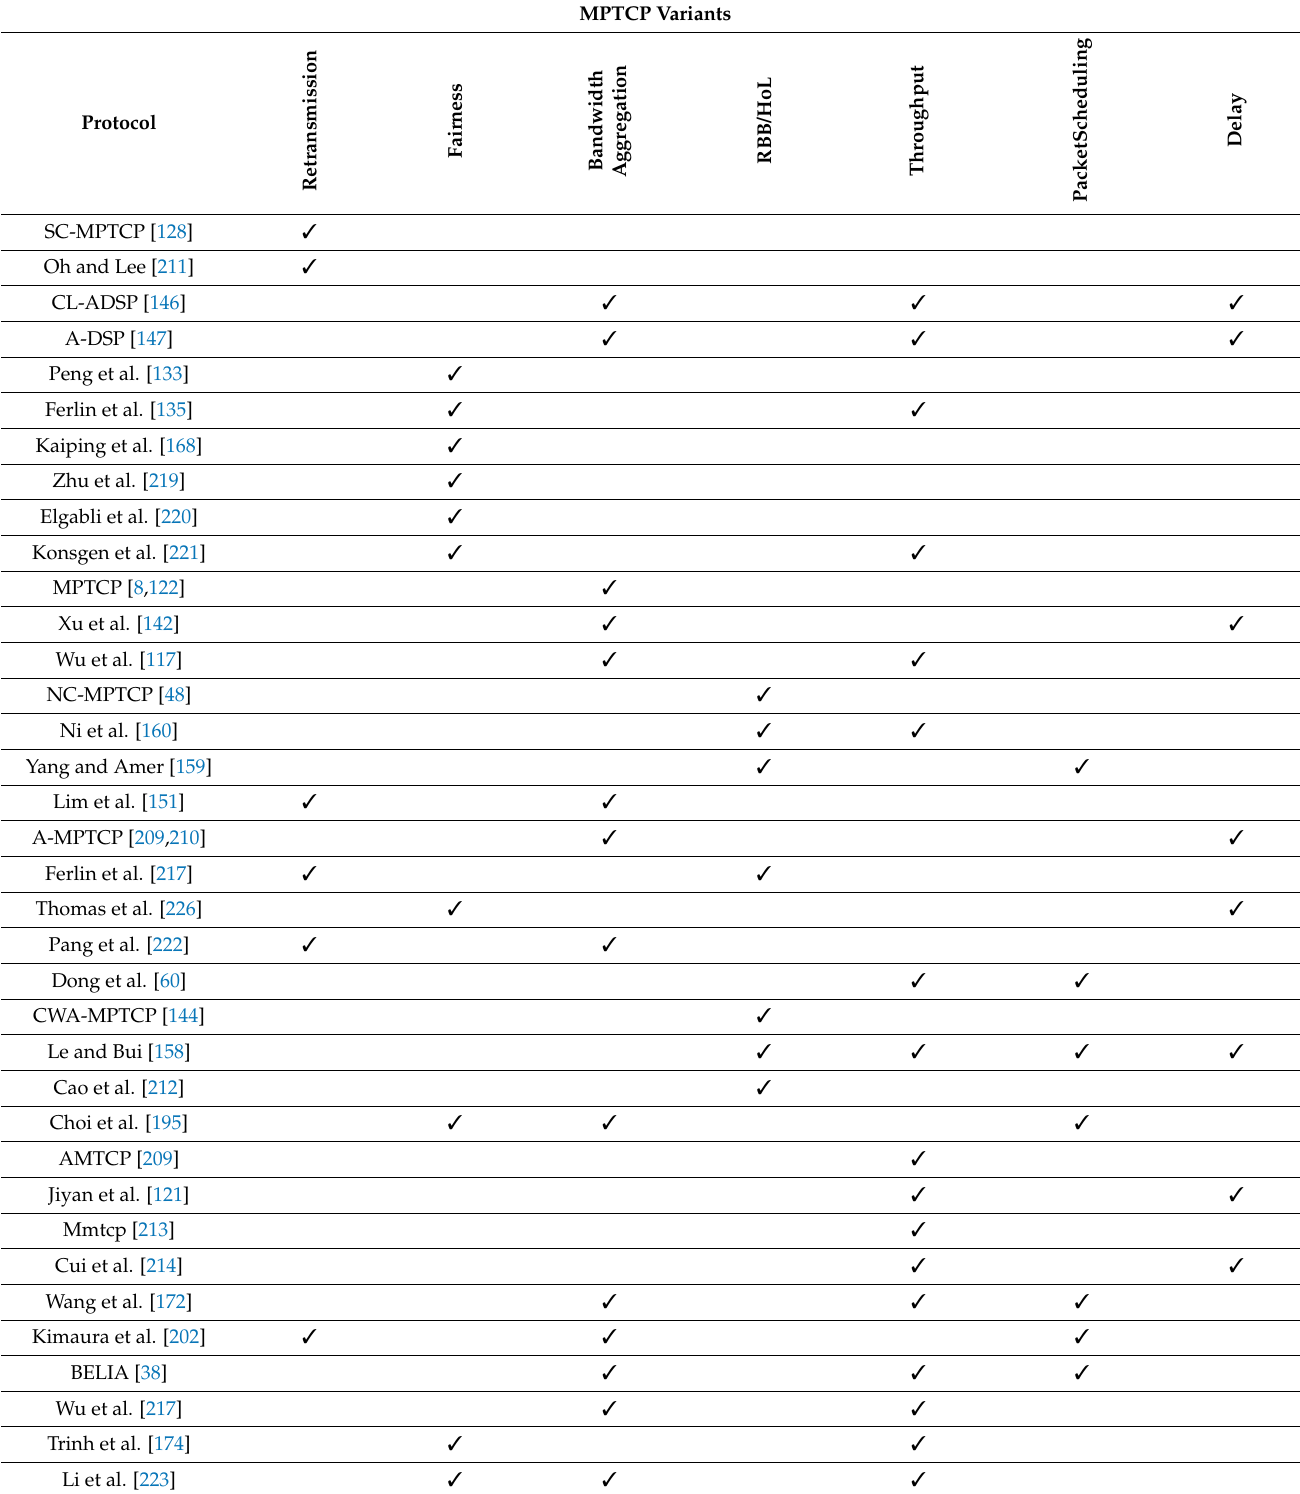
Table 5. A categorization of MPTCP